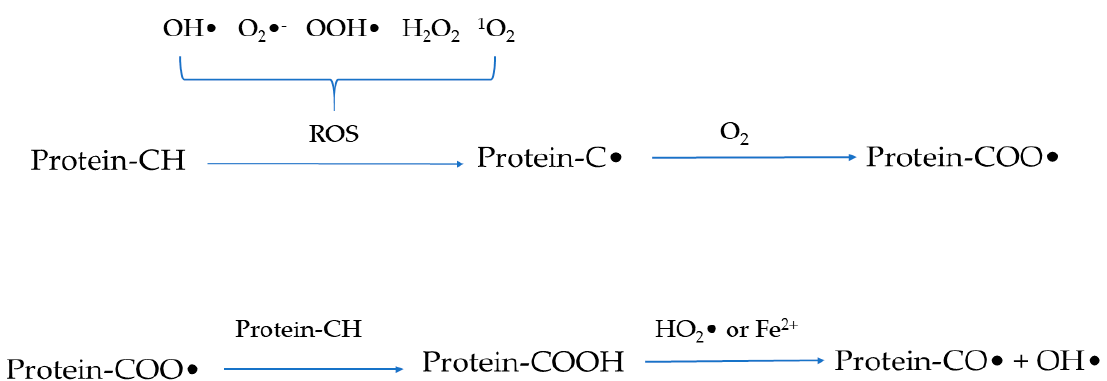
Figure 2. Schematic representation of the mechanism of protein oxidation. In addition to free radical-induced protein oxidation, lipid peroxidation and non- enzymatic glycosylation can indirectly mediate the oxidation modification of proteins. Lipid peroxidation is inevitable during the processing and storage of muscle foods, leading to the formation of many intermediate products such as alkylperoxyl radicals, alkoxy radicals, reactive carbonyl compounds, hydroperoxide, and others. Alkylperoxyl and alkoxy radicals can react at the peptide backbone and amino acid side chain groups while reactive carbonyl compounds can interact with the side chain groups of protein to form covalent cross-links [22]. In the meantime, hydroperoxide can react with protein to form an amide adduct via the ε -amino pathway. The reactive aldehydes produced from the lipid peroxidation reaction are mainly α , β -unsaturated aldehydes [23], which possess a high ability to induce protein oxidative denaturation [3,24]. On the other hand, non- enzymatic glycosylation also gives rise to the oxidation of proteins [25]. Additionally, ROS are involved in mediating the acceleration of non-enzymatic glycosylation, and the products produced by the glycosylation reaction can react with proteins, further leading to the occurrence of protein